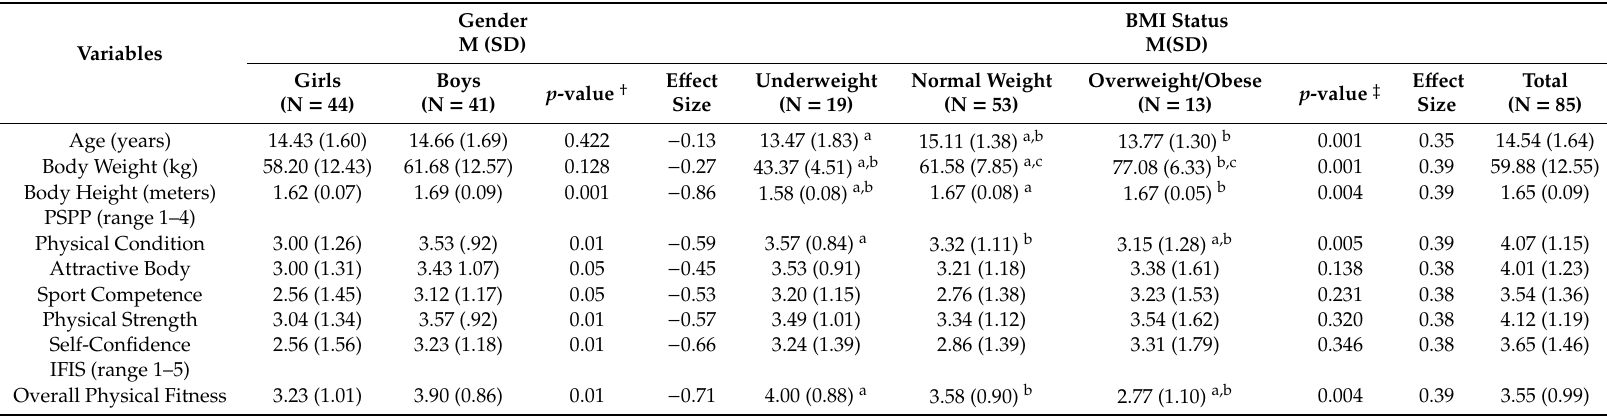
Table 1. Clinical Characteristics, physical self-perception profile (PSPP) domains and overall physical fitness through international fitness scale (IFIS) of adolescent students by gender and body mass index (BMI) status.